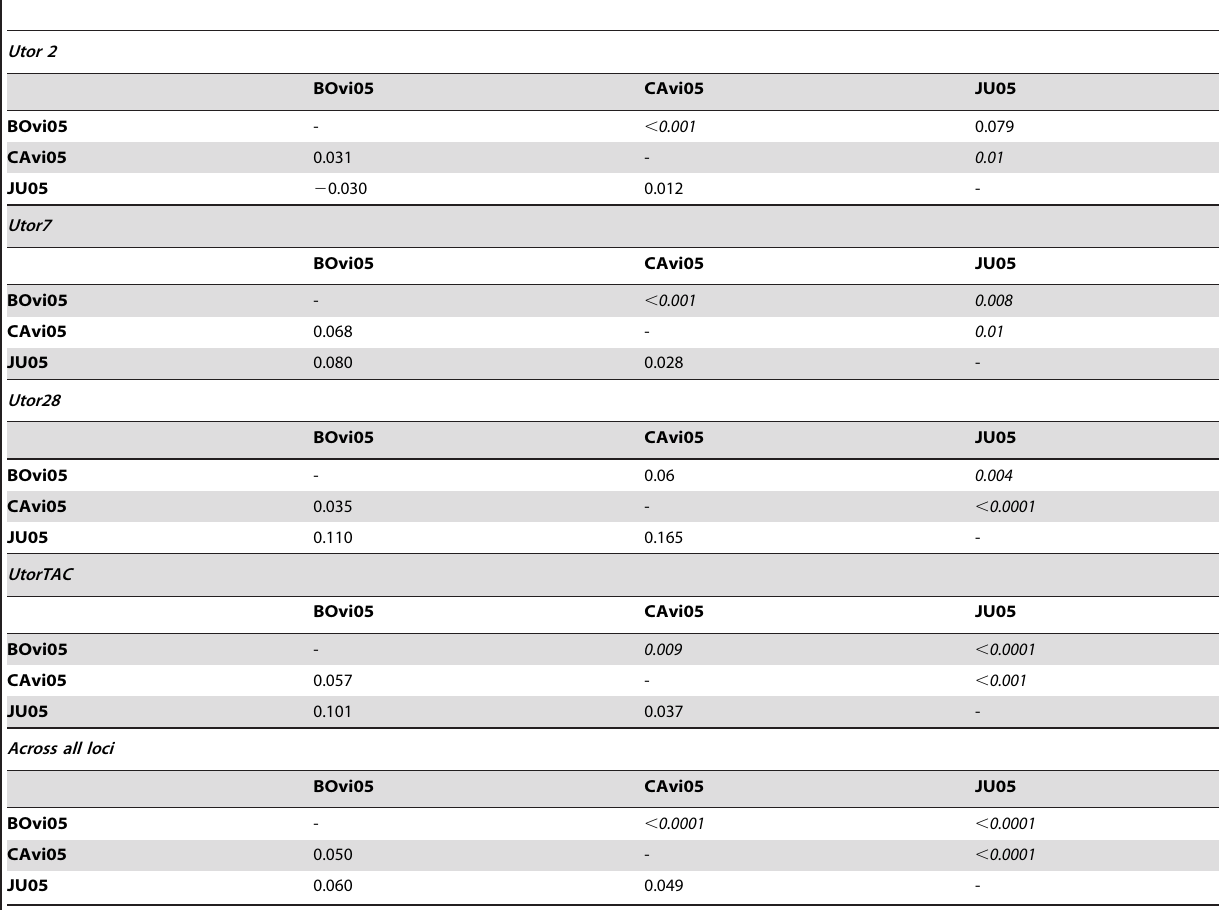
Table 4. Utetheisa ornatrix population differentiation at the regional scale in 2005.